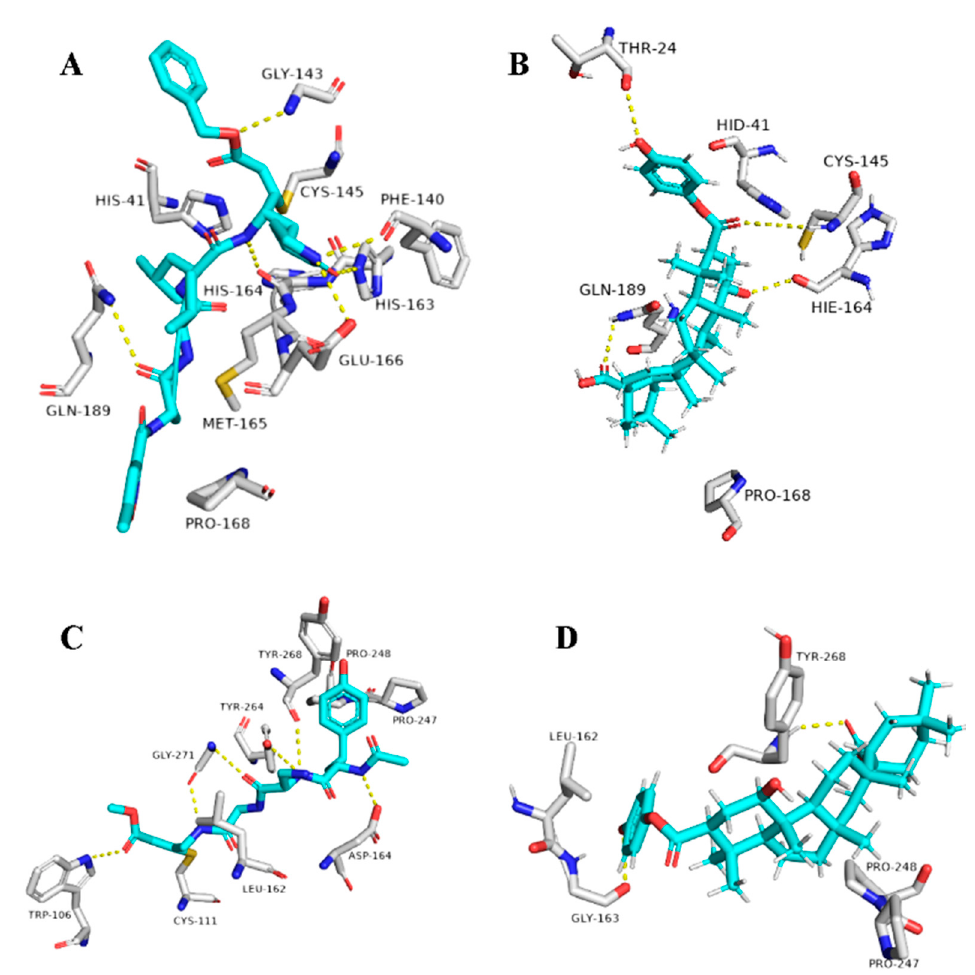
Figure 8. Binding modes of 1ß-Hydroxyaleuritolic acid 3- p -hydroxybenzoate (11) inside SARS-CoV-2 targets. ( B , D ) Interactions inside both M pro and PL pro , respectively. ( A , C ) co-crystallized ligands of both M pro and PL pro ,